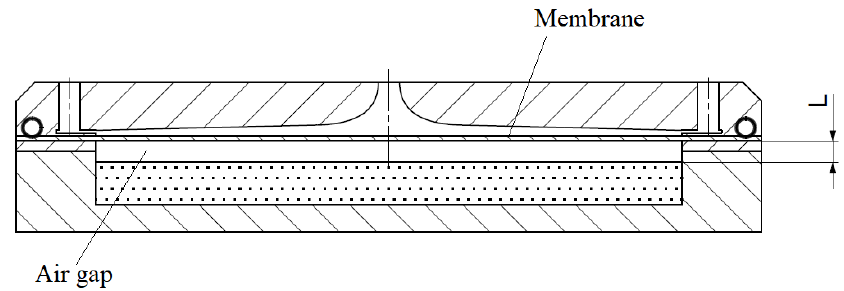
Figure 7. FLEC with